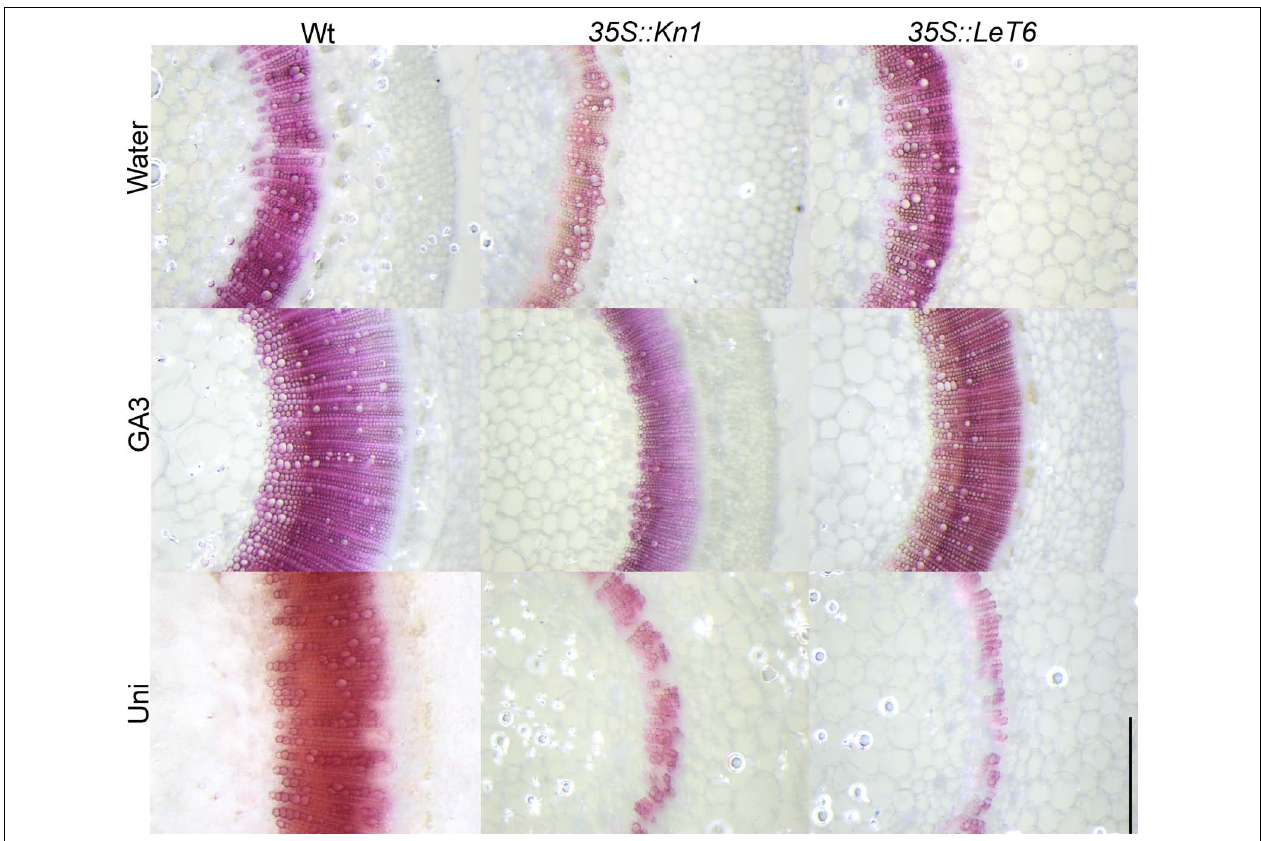
FIGURE 4 | Effects of gibberellic acid3 (GA3) and uniconazole (Uni) treatment on stems of wild-type (Wt) and transgenic 35S::LeT6 and 35S::Kn1 tobacco plants. Stem cross sections were stained with phloroglucinol. Scale bar = 0.5